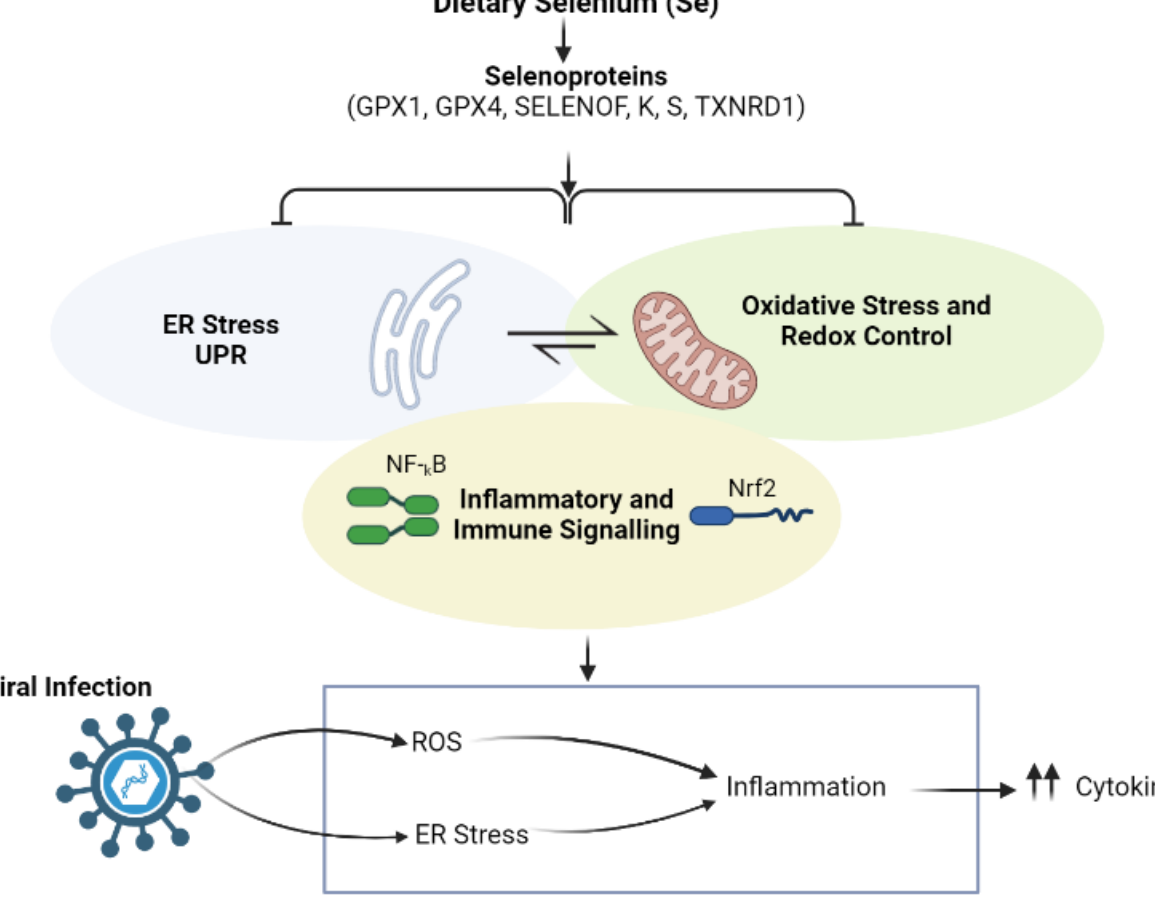
Figure 2. The role of dietary selenium (Se) in viral infections.